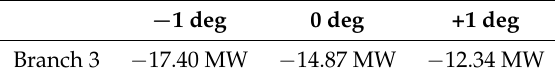
Table 1. Power flows for a PST with ω = ± 1 degree.